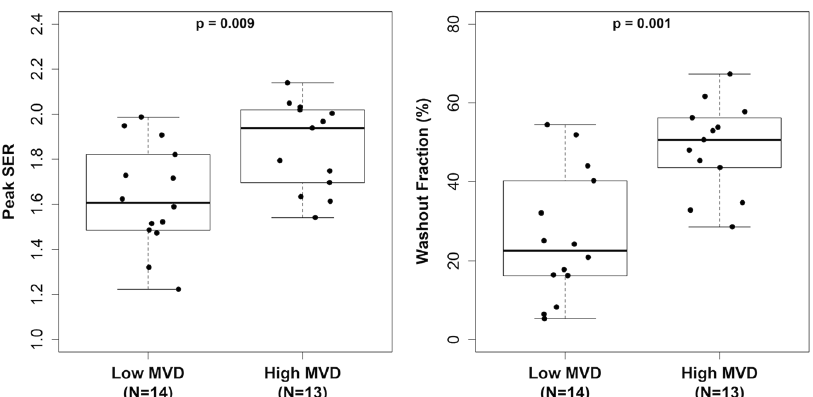
Fig. 1 DCE-MRI kinetics features associated with microvessel density. Two kinetics features signi fi cantly differentiated lesions with low versus high microvessel density (MVD). Box-and-whisker plots represent the median (solid line), inter-quartile range (IQR; box), and range of the dynamic contrast-enhanced (DCE)-MRI metrics. The whiskers extend up to 1.5 times the IQR from the box to the smallest and largest points. Lesions with higher MVD based on CD31 staining on average demonstrated higher peak signal enhancement ratio (SER; AUC: 0.79, p = 0.009, left) and higher washout fraction (AUC: 0.87, p = 0.001, right).